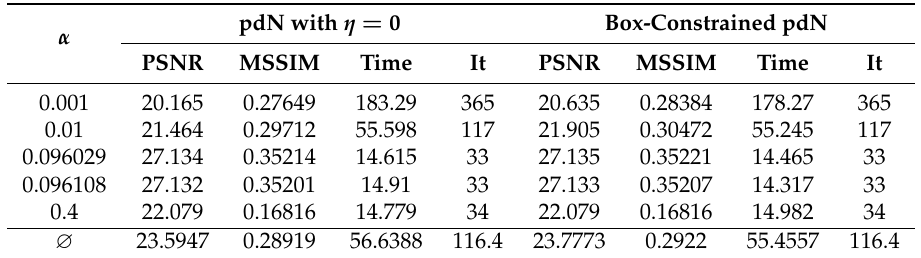
Table 1. Reconstruction of the cameraman-image corrupted by Gaussian white noise with σ = 0.1 for different regularization parameters α .